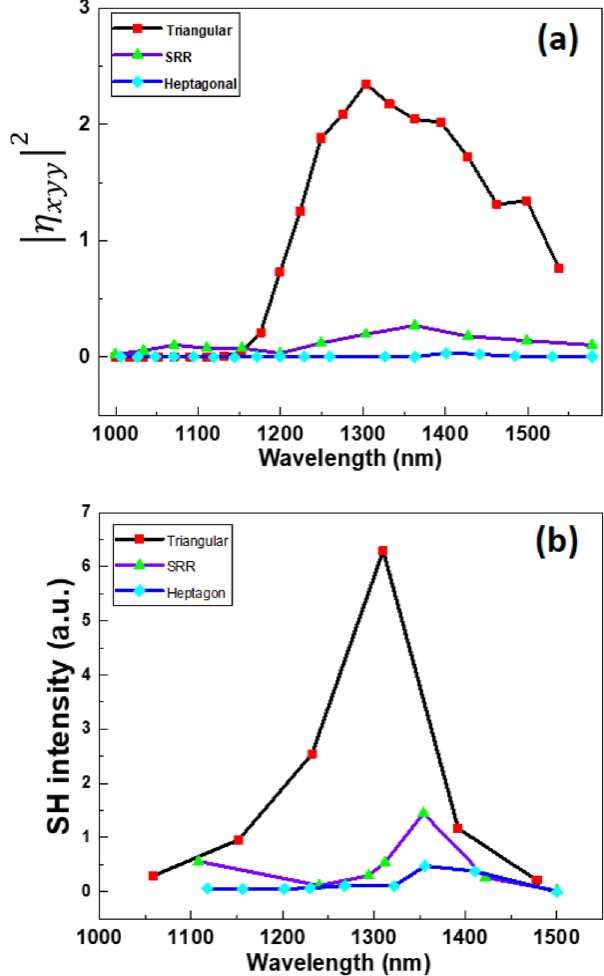
Fig. 4. Comparison of SHG intensity as a function of funda- mental wavelength. (a) Numerical calculation, (b) Experimental